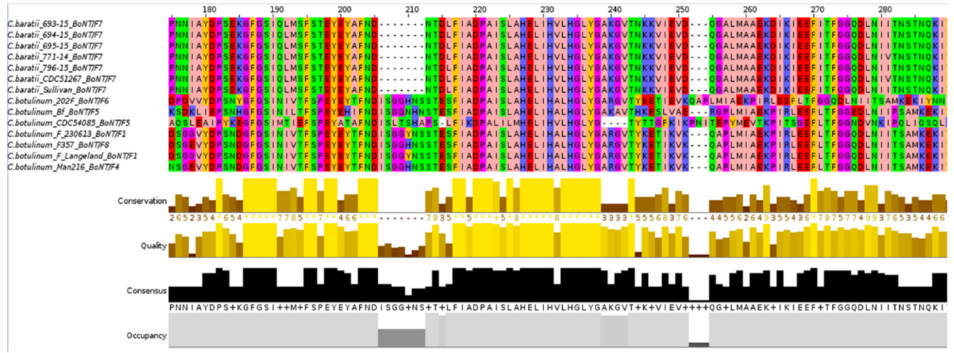
Figure 8. BoNT gene alignment. Alignment of BoNT gene in C. baratii and C. botulinum strains. C. baratii strains do not have 7 amino acids present in the BoNT gene of C. botulinum in position